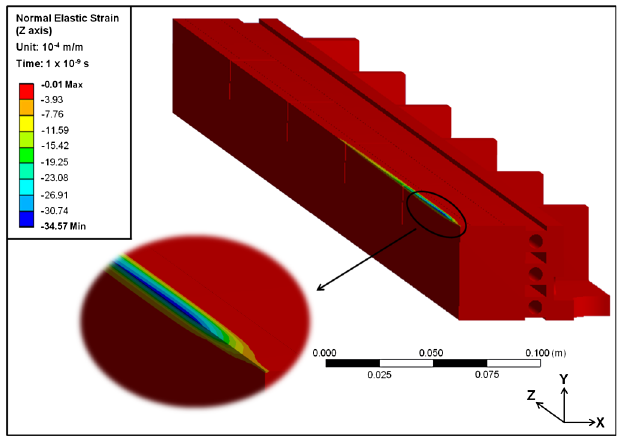
FIG. 14. Normal elastic strain along the z-direction on the collimator jaw assembly after the nominal ion beam impact. A detailed view is shown in the inset. A similar plot with comparable peak values has been achieved for the case of the proton beam impact ( 4 . 48 × 10 9 protons).